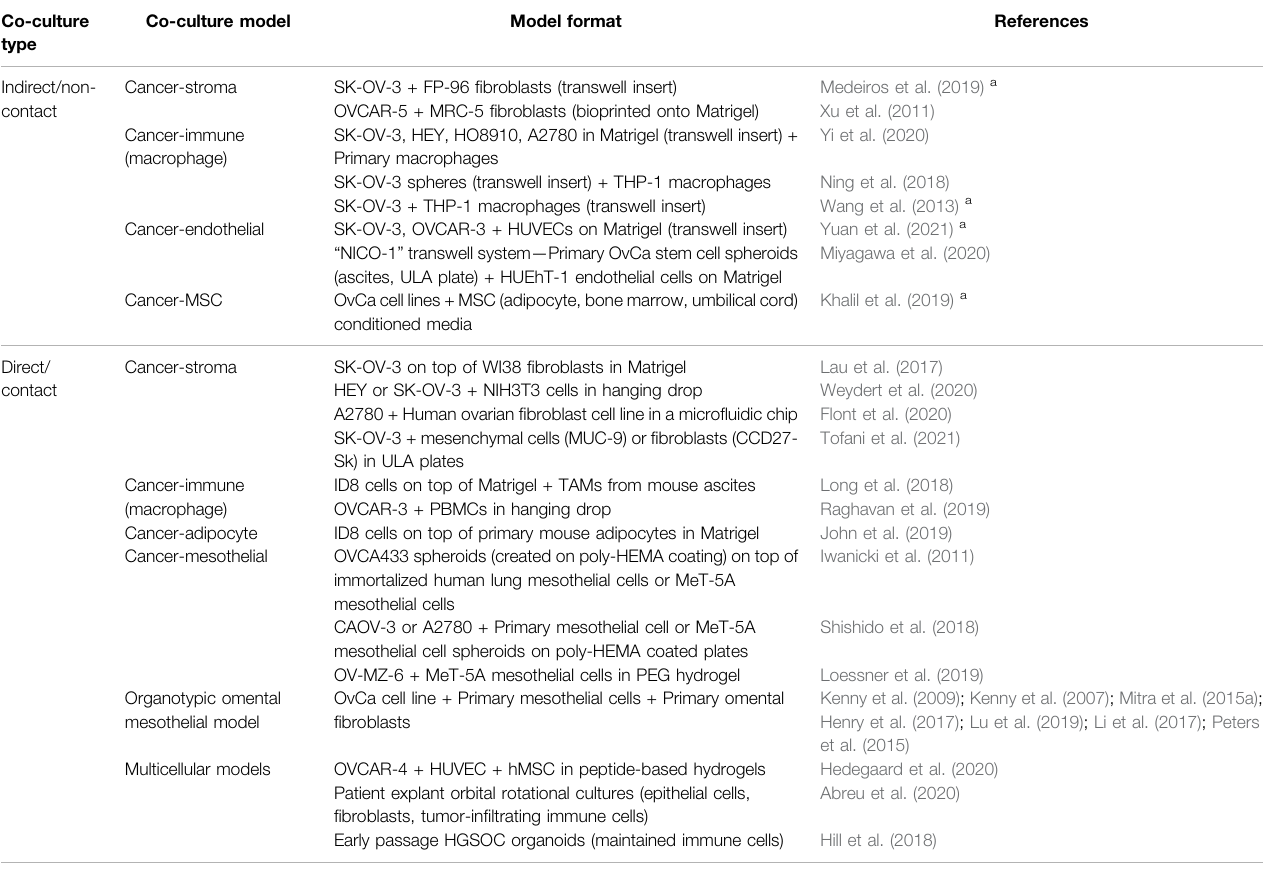
TABLE 3 | Indirect and direct in vitro ovarian cancer co-culture